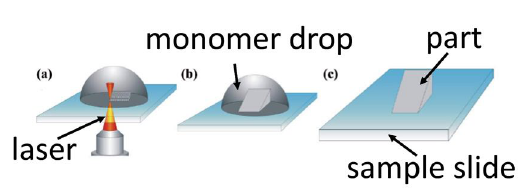
Figure 1. Schematic: multiphoton lithography [2] To move from a dot to a defined 3D structure, the desired geometry has to be prepared by a slicer. The slicer disassembles the model into a number of slices with constant height. A smaller height results in a better resolution.